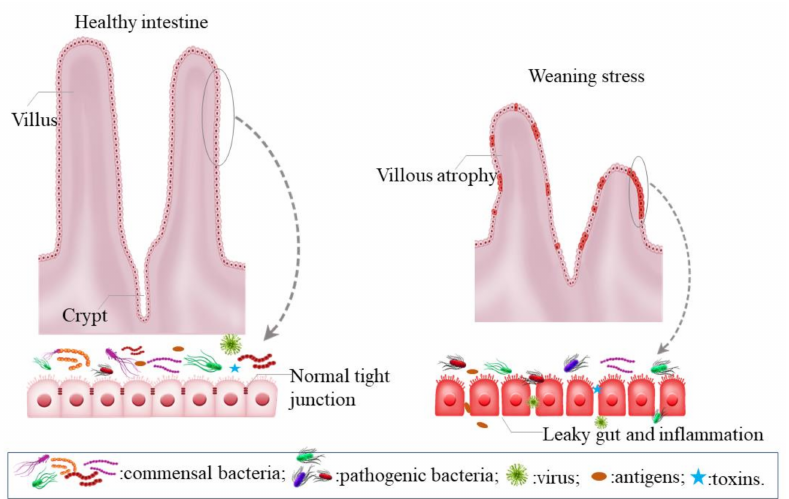
Figure 1. Negative impacts of weaning stress on swine gut